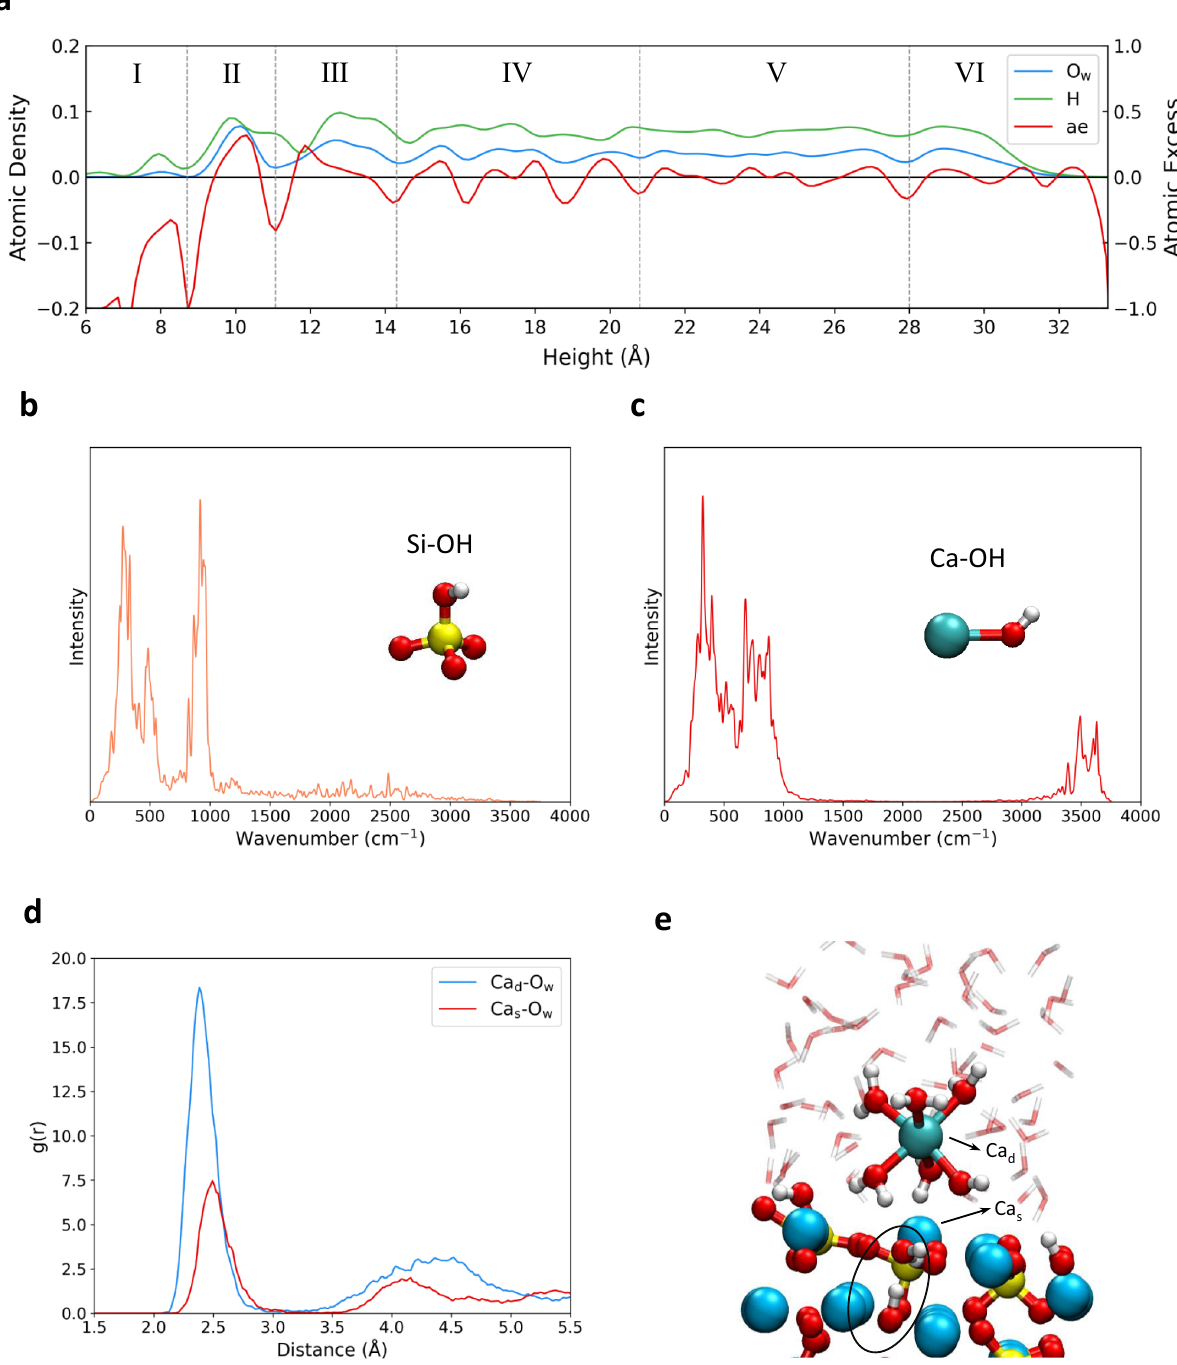
Fig. 5 The structural and spectroscopy analysis of the water/Ca 3 SiO 5 interface after the dissolution of Ca. a Atomic density for O w and H, and atomic excess pro fi les as a function of the height beginning at 6 Å from the bottom of the Ca 3 SiO 5 surface. b , c The calculated IR spectrums for Si – OH group and Ca – OH group, respectively. d Radial distribution function (RDF) between the dissolved Ca ion (Ca d ) and the O w ion as well as between the surface Ca ion in the same site (Ca s ) and the O w ion. e The snapshot of the equilibrium AIMD after 30